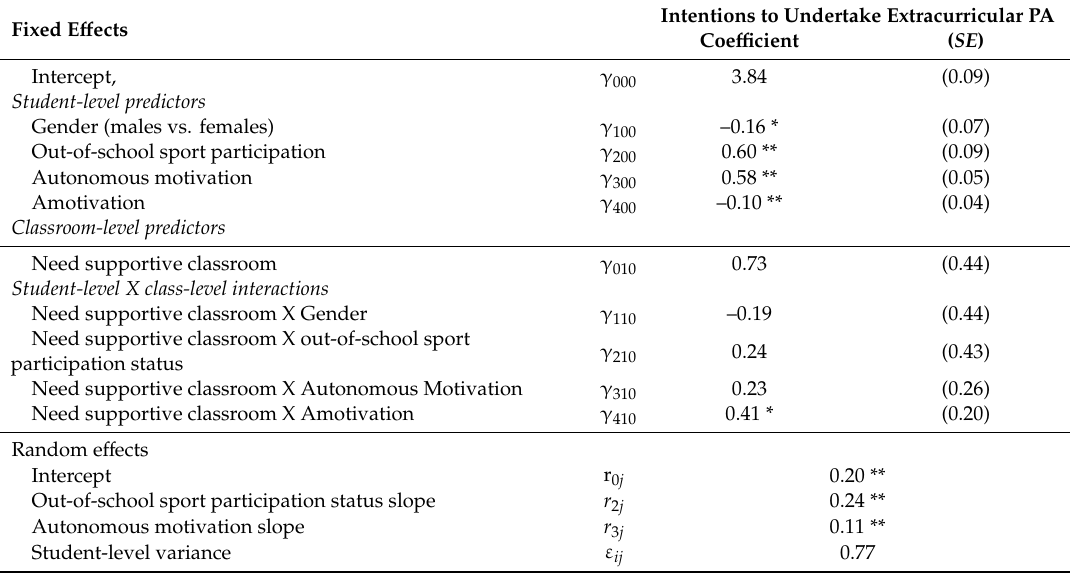
Table 3. The multilevel model predicting intentions to undertake extracurricular